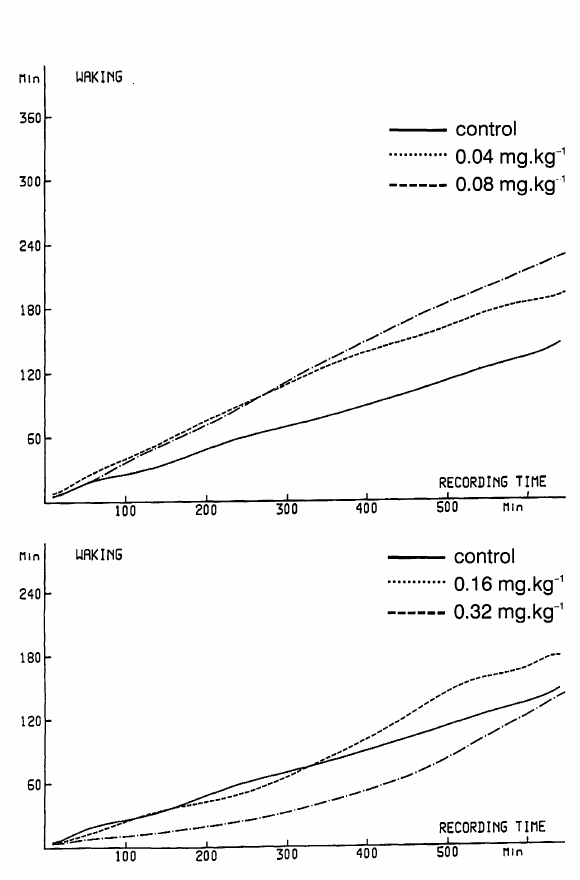
FIG. 1. General trends for wakefulness after different doses of clonidine.